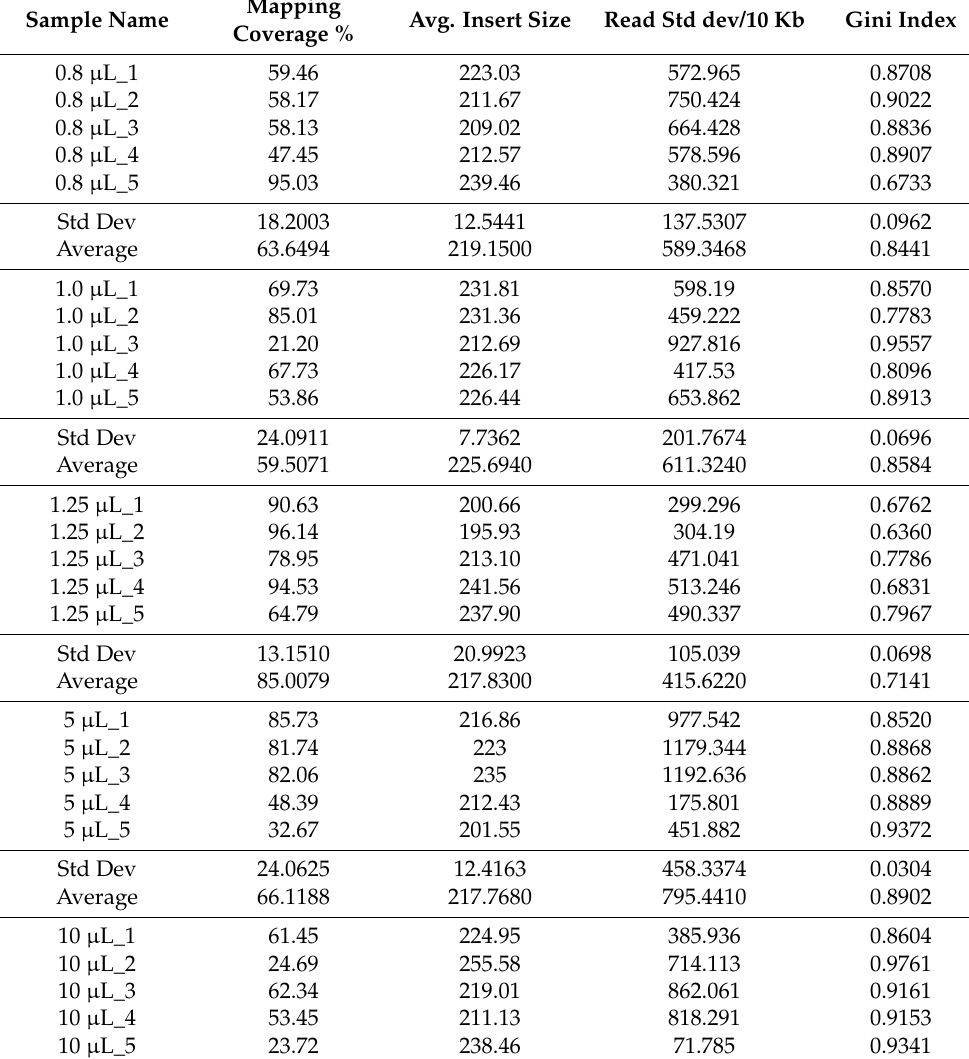
Table A4. MDA read mapping summary. After contaminant and duplicate removal, reads